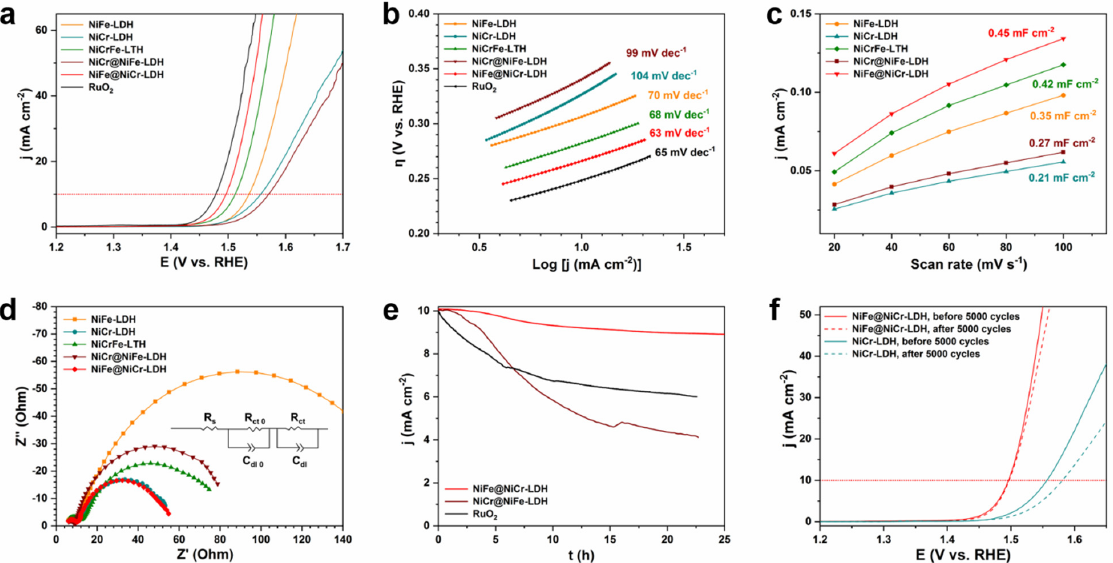
Figure 4. ( a ) LSV polarization curves and the corresponding Tafel plots ( b ) of NiFe@NiCr-LDH, NiCr@NiFe-LDH, NiCrFe-LTH, NiCr-LDH, NiFe-LDH, and RuO 2 in 1.0 M KOH; ( c ) The current density at 1.18 V vs. the scan rate for NiFe@NiCr-LDH, NiCr@NiFe-LDH, NiCrFe-LTH, NiCr-LDH, and NiFe-LDH; ( d ) Electrochemical impedance spectra (EIS) of the samples; ( e ) The i-t curve at the current density of 10 mA cm − 2 for 24 h; ( f ) The LSV polarization curves of the NiFe@NiCr-LDH and NiCr-LDH catalyst before and after 5000 CV cycles.